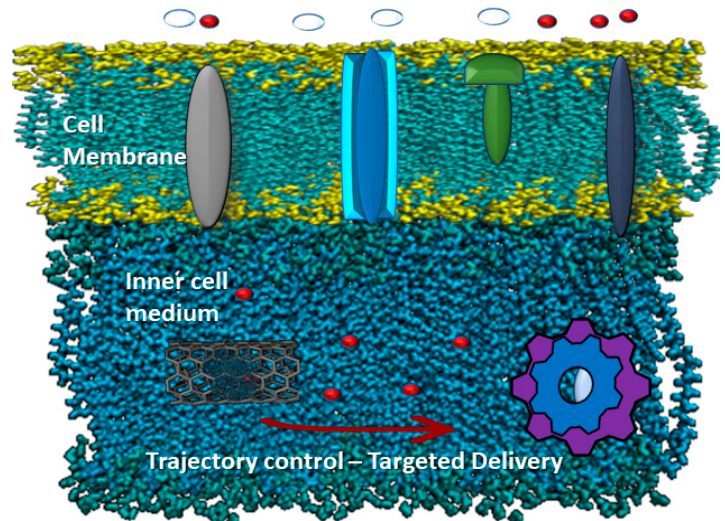
Figure 2. Functionalized CNTs crossing through the membrane. With a predefined magnetic field, CNTs can be guided through a desired trajectory inside the cell. The magnetic forces needed in this step are lower than those needed later, as the resistance forces are lower than they are inside the cell and cytoplasm.